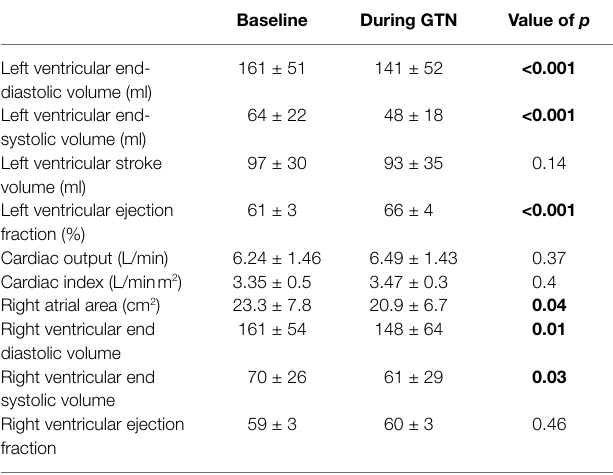
TABLE 2 | Left and right heart measurements at rest and during GTN infusion. Baseline During GTN Value of